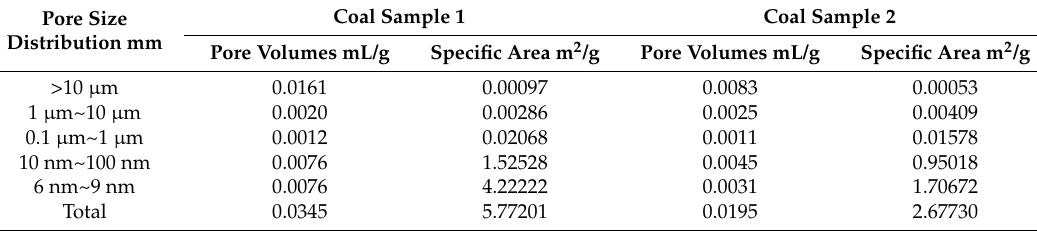
Figure 4. Testing results of MIP experiments: ( a ) Curves to summarize mercury intrusion and evacuation from the two coal samples assessed in this research; ( b ) pore size distribution curves for the two coal samples assessed in this research; ( c ) specific surface area distribution curves for the two coal samples assessed in this research. Table 2. Pore volumes and specific surface areas of coal Samples 1 and 2 across different size ranges